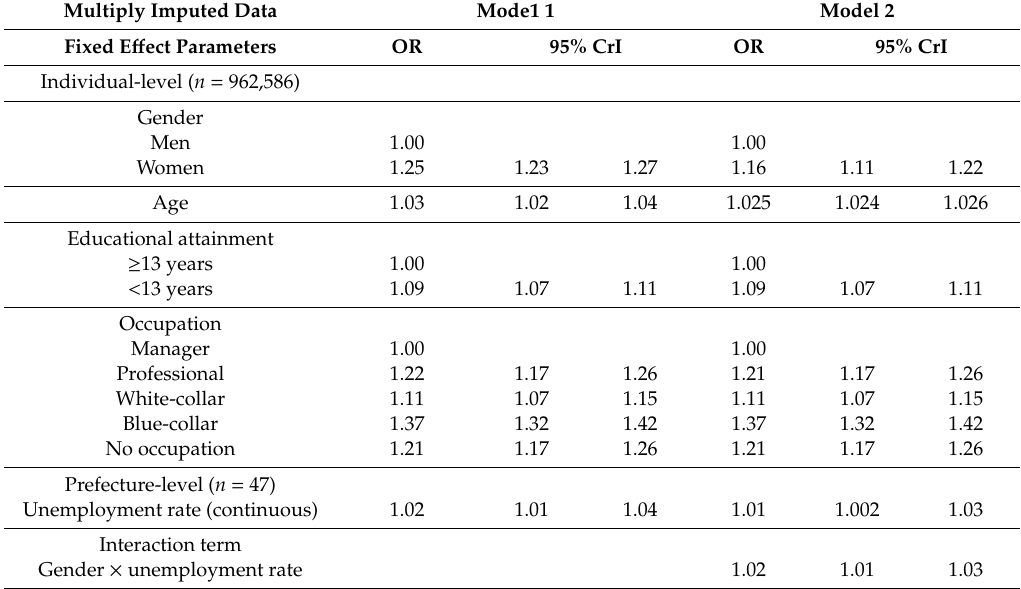
Table 2. Association between unemployment rate and lower back